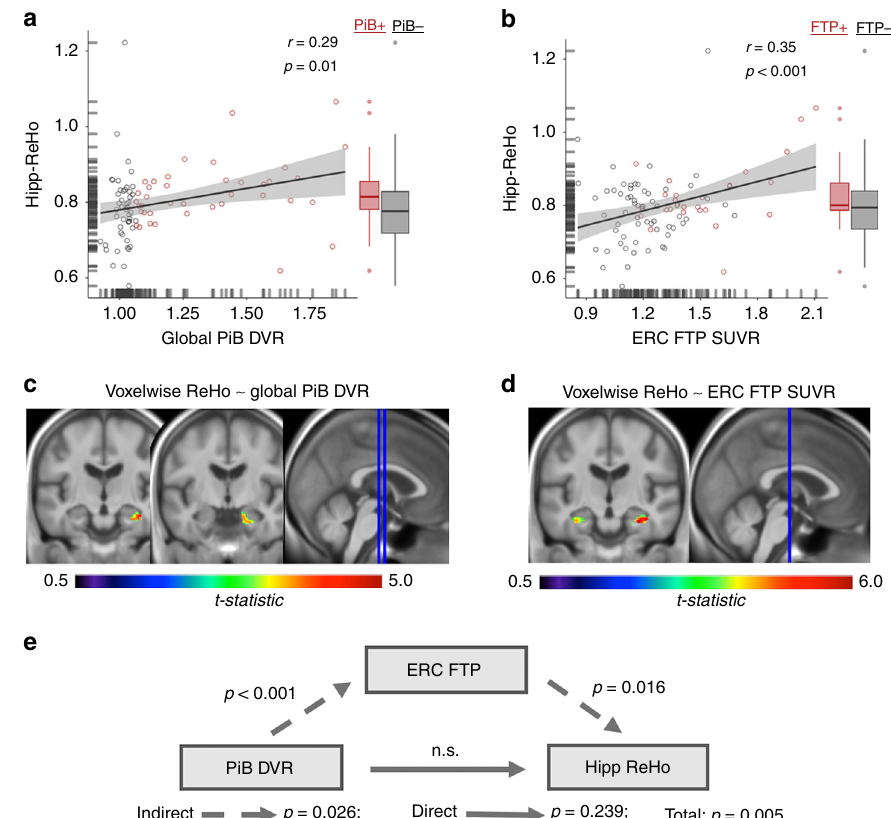
Fig. 3 Hipp-ReHo is associated with AD pathology in older adults. a Global PiB DVR (PiB + in red; PiB- in gray; threshold DVR > 1.065) positively predicted hipp-ReHo ( r = 0.29, p = 0.01; all r and p -value pairs re fl ect Pearson correlation). Global PiB DVR remained a signi fi cant predictor of hipp-ReHo after adjusting for age, sex, and hippocampal volume. The band within the boxplots represents the median while the upper and lower edges of the box represent the fi rst and third quartiles, respectively. The whiskers extend up to 1.5 times the interquartile range. Data points outside this range are plotted as outliers. b ERC FTP SUVR (FTP + in red; FTP- in gray; threshold SUVR > 1.26 in Braak III/IV) was a positive predictor of hipp-ReHo ( r = 0.35, p < 0.001). ERC FTP SUVR remained a signi fi cant predictor of hipp-ReHo after adjusting for age, sex and hippocampal volume. Illustrative boxplots are used as in panel A. c , d Voxelwise regressions of ReHo images spanning all gray matter voxels with global PiB DVR or ERC FTP SUVR as the independent variable of interest illustrate signi fi cant clusters (cluster corrected p < 0.05) predominantly within the hippocampus. e A mediation analysis testing if ERC FTP SUVR mediates the observed relationship between PiB DVR and hipp-ReHo revealed a signi fi cant mediation effect (indirect path p = 0.025; direct path p = 0.239; total p = 0.005). Source data are provided as a Source Data fi le. ReHo regional homogeneity, PiB Pittsburg compound B, DVR distribution volume ratio, ERC entorhinal cortex, FTP fl ortaucipir, SUVR standardized uptake value